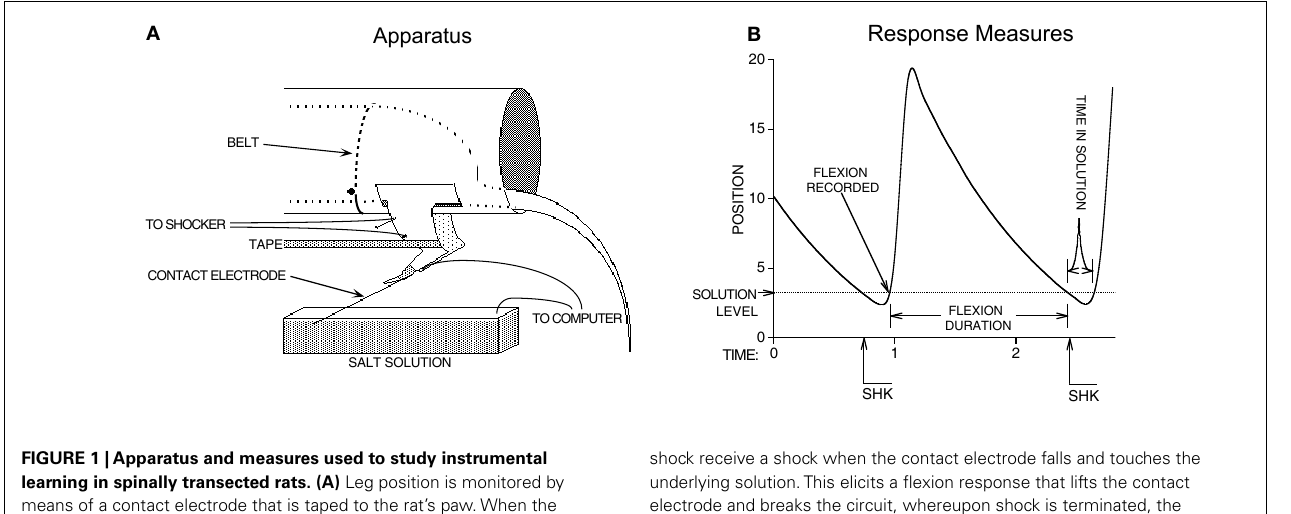
shock receive a shock when the contact electrode falls and touches the underlying solution.This elicits a flexion response that lifts the contact electrode and breaks the circuit, whereupon shock is terminated, the duration of solution contact is recorded, and response number is incremented by one.Yoked animals receive shock independent of leg position and the same criteria are used to monitor time in solution and response number. Adapted from Grau et al.